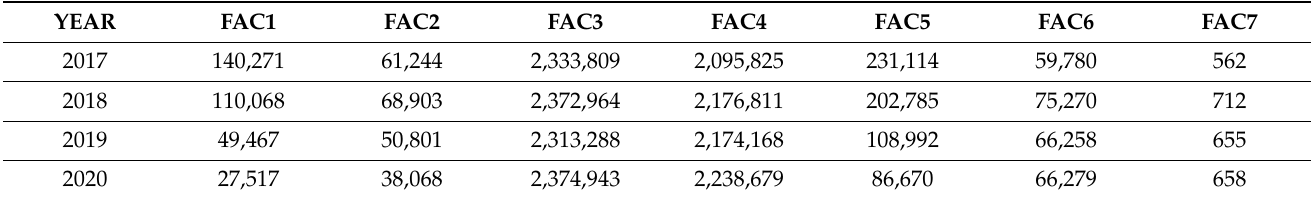
Table 15. Data on business results (2017 −